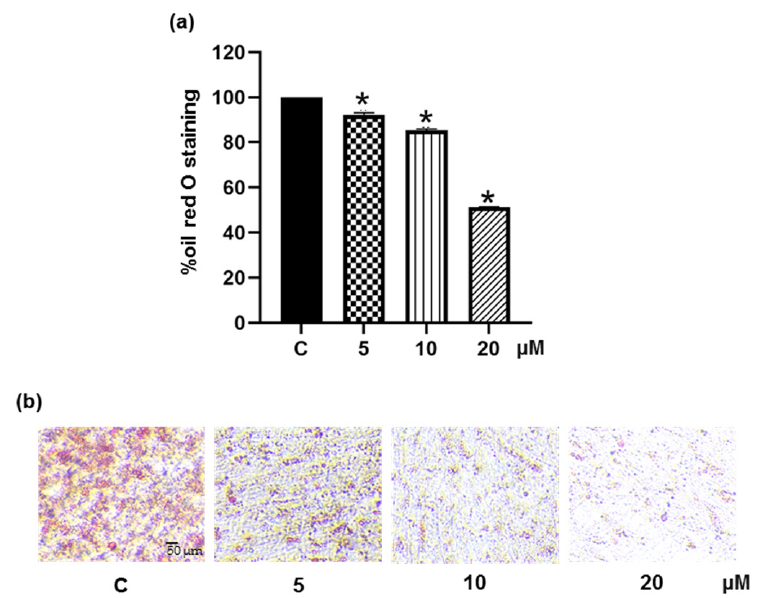
Figure 8. Suppressive effect of pinostrobin on adipogenic differentiation in human pre-adipocytes. Human PCS-210-010 pre-adipocytes were induced into matured adipocyte by culturing with differ- entiated medium in presence of 0–20 µM pinostrobin for early 48 h. After differentiation, cellular lipid was stained with oil red O solution for detecting ( a ) the lipid content representing as % oil red O and ( b ) accumulated lipid droplets observed under a microscope. Data represent the mean ± SD. * p < 0.05 compared with vehicle control cells (C) treated with 0.5% DMSO.